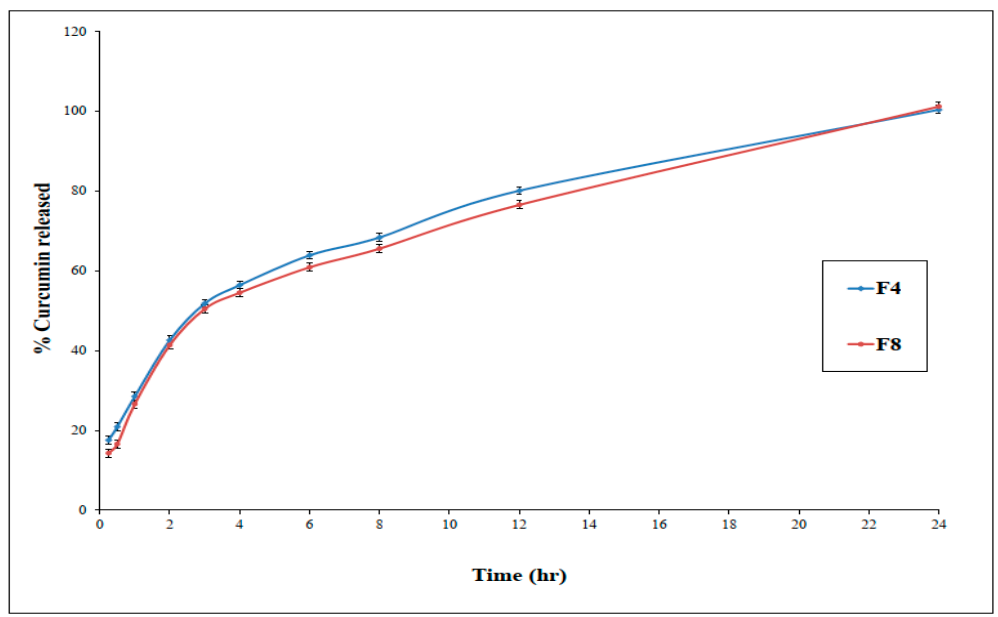
Figure 3. In-vitro release of curcumin from optimized proniosomal gel formulations F4 and F8 (±SD, n = 3).